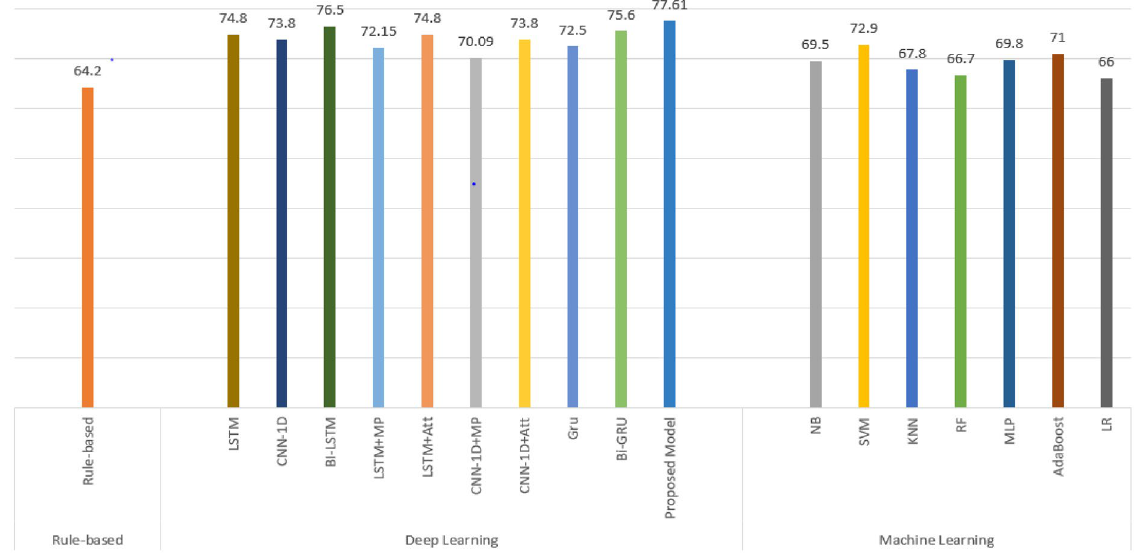
Figure 5. Accuracy Comparison of Machine, Deep Learning and Rule-Based Approaches with Proposed Model using UCSA-21 Corpus.